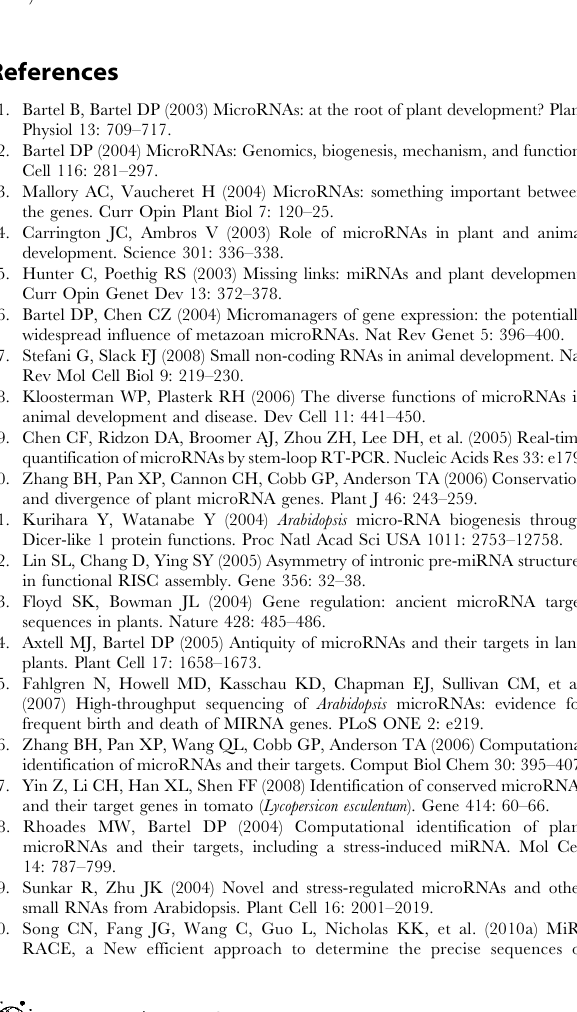
Table S1 Comparison of Vv-miRNA sequences predi- cated in silico and the validated by miR-RACE. Table S2 Predicted target genes or proteins for grape- vine miRNAs validated by miR-RACE. Table S3 Comparison of target genes of experimentally verified orthologous miRANs in grapevine and Arabi- dopsis . Table S4 Primers used for miR-5 9 RACE, miR-3 9 RACE. Table S5 Primers used for real-time PCR of Vv- miRNAs. Table S6 Primers used for real-time PCR of target